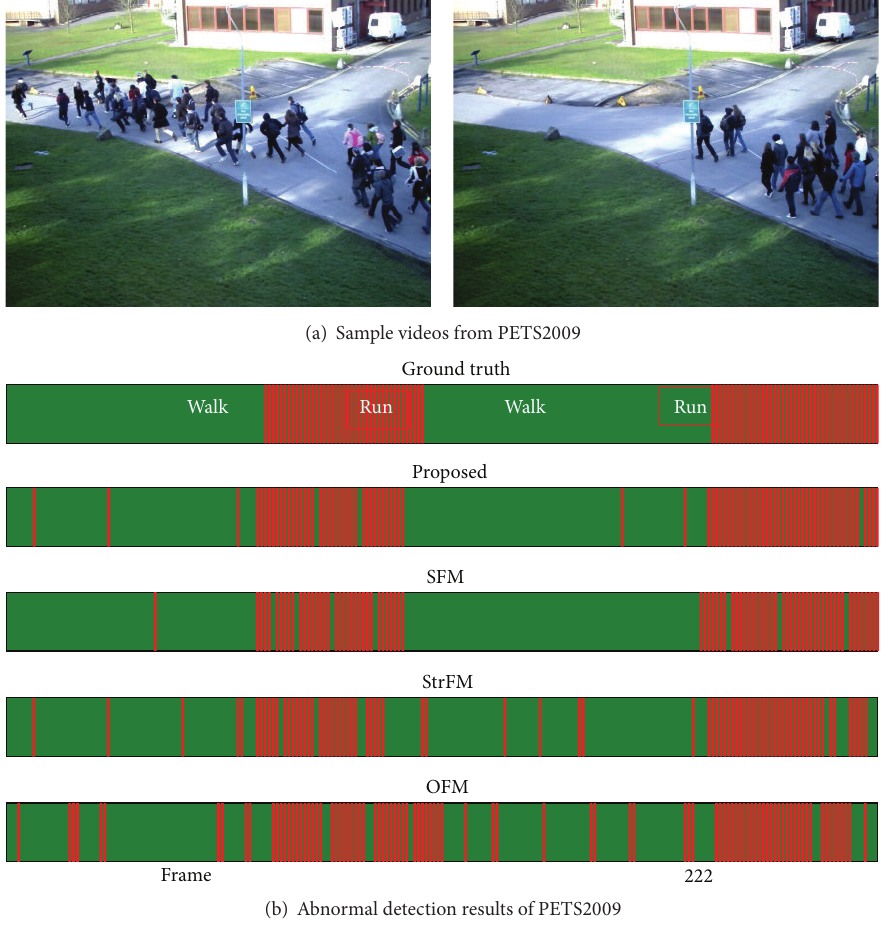
Figure 7: Comparison results of abnormal detection for sample videos from